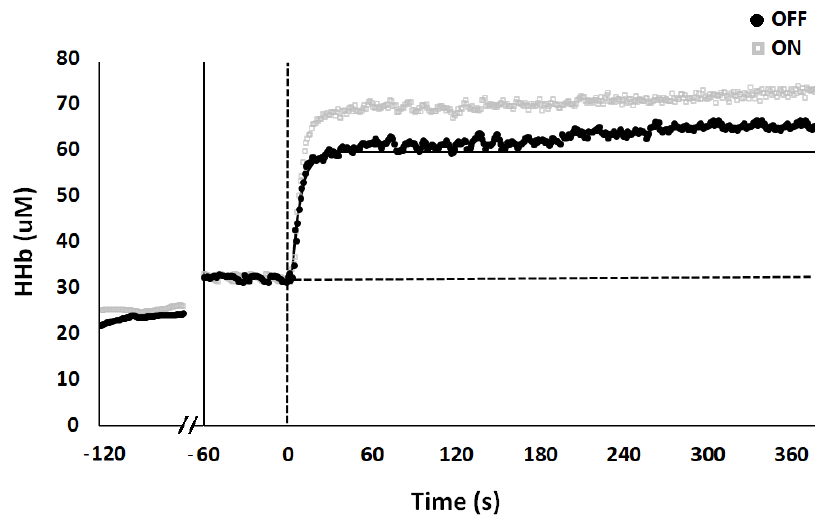
Figure 2. Model fit for HHb kinetics between conditions, OFF (black dot) and ON (grey square) for a typical subject. The first 60 s represent HHb values recorded when subject was stationary on the bike, just before baseline values (subsequent 60 s). Vertical dotted line at time 0 represents the transition from unloaded cycling (baseline) to constant load exercise. Horizontal dashed line represents baseline. Data points are average values calculated each second.